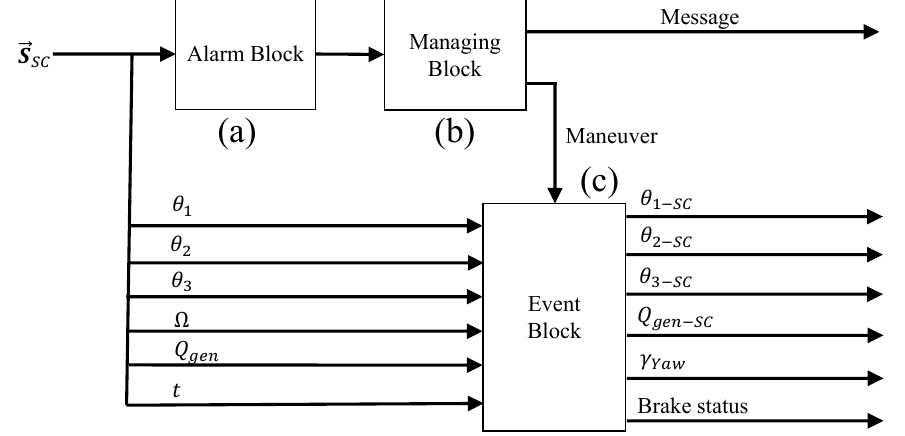
Figure 5. Overview of the supervisory control. It comprises an alarm block, a managing block and an event block. The latter can be used to trigger specific events such as controller faults that are required for a full load